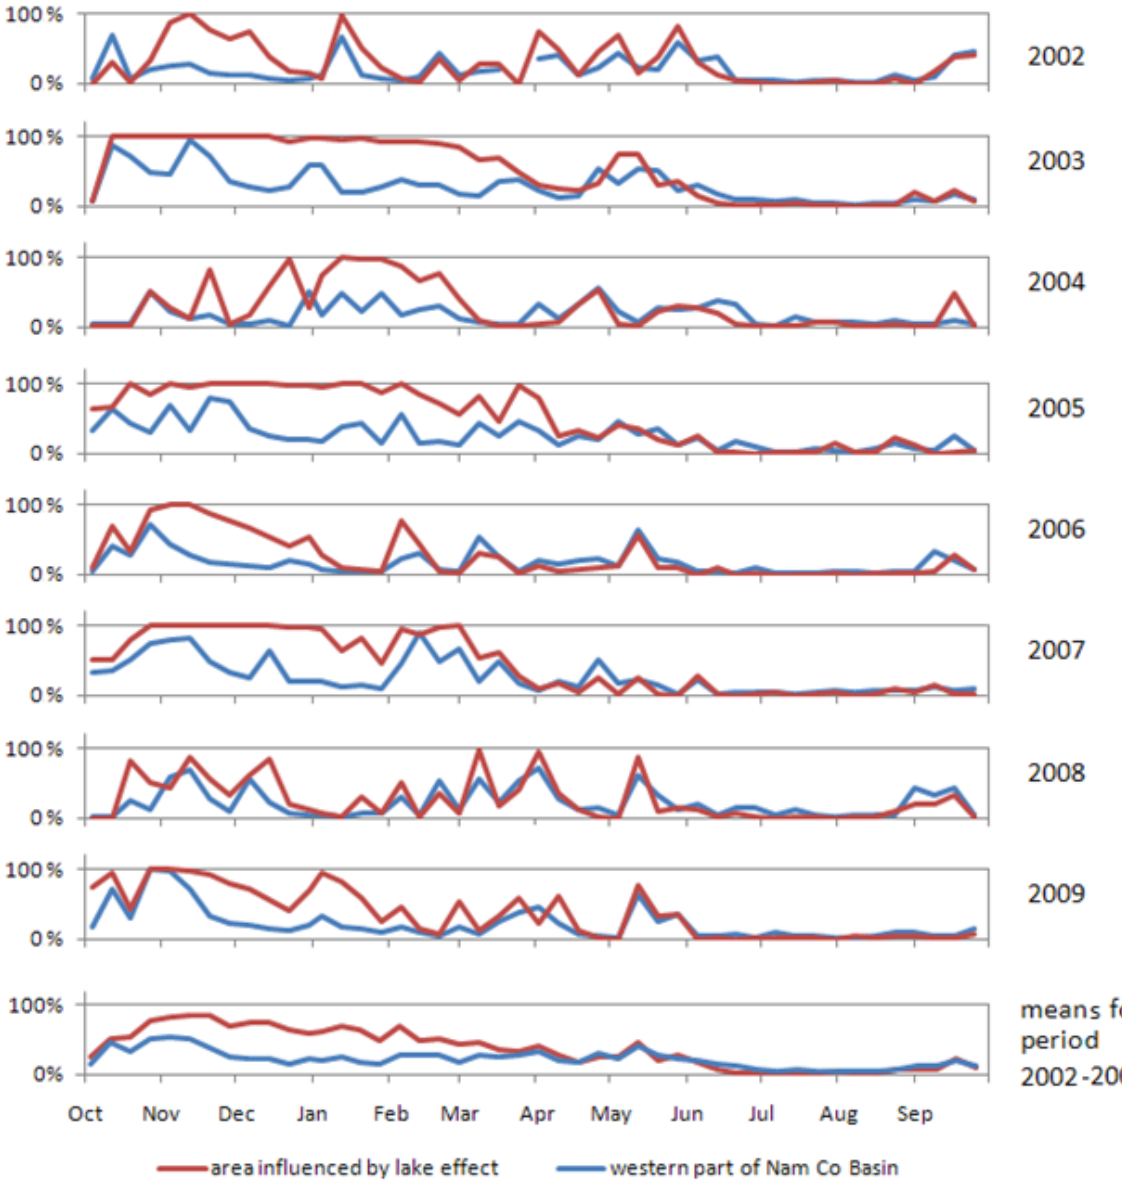
Figure 5. Percentage of snow covered area from October to September in years 2002–2009 from 8-day composites of MODIS Terra Snow data. The area affected by the lake effect and the rest of the basin (excluding the lake) are plotted separately. 100% corresponds to complete snow cover of the